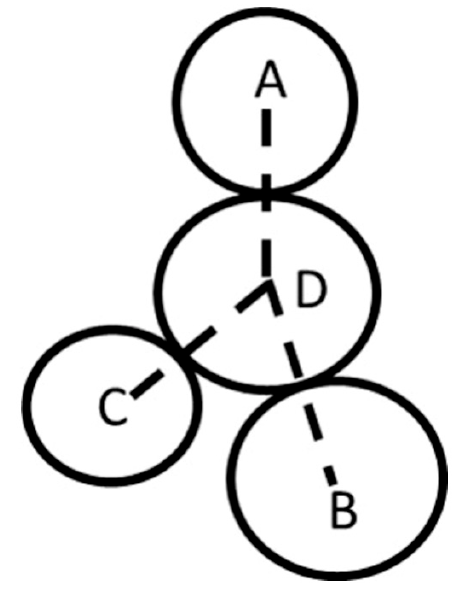
Figure 2. The concept of the stability index.